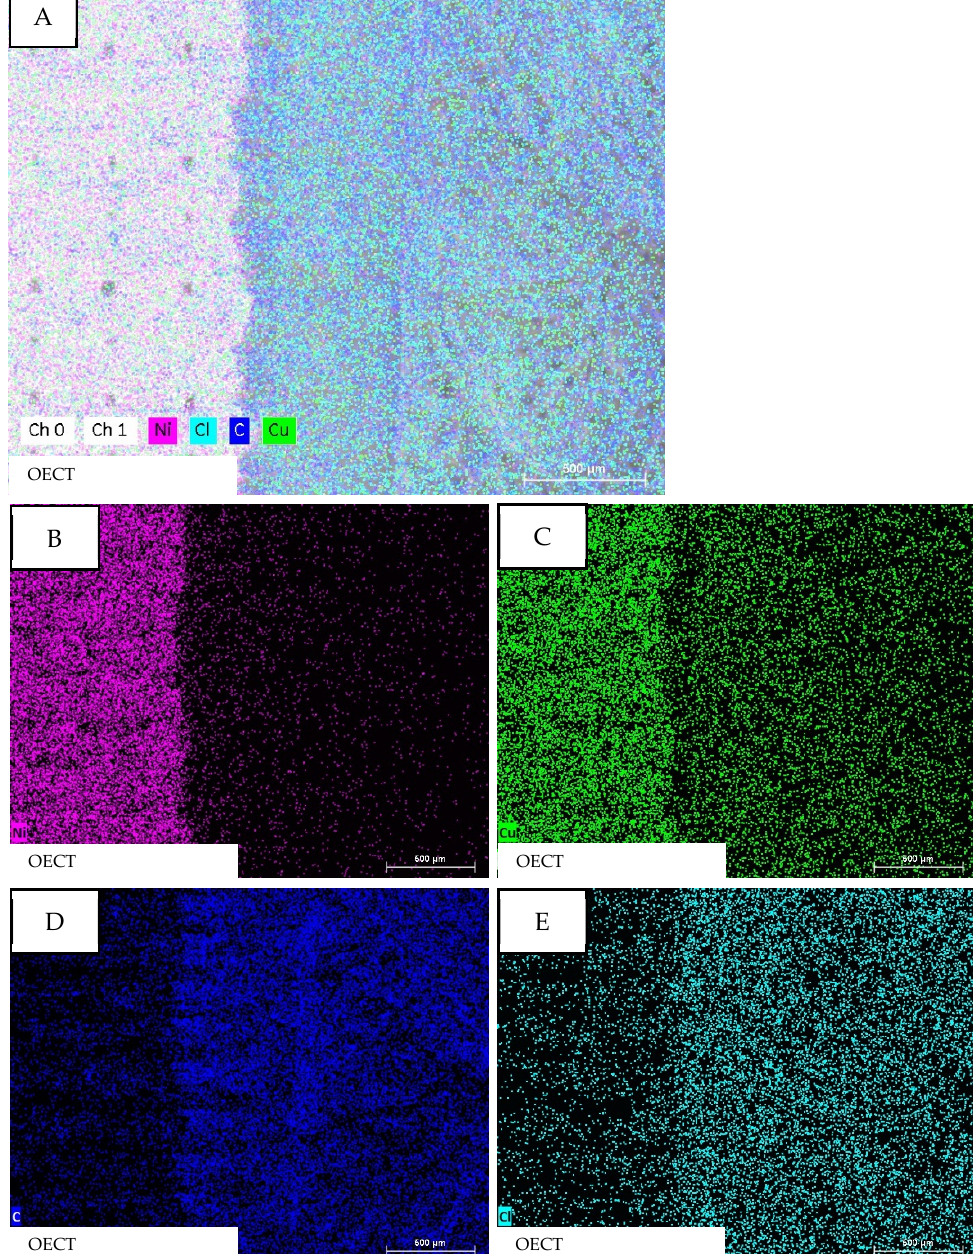
Figure 6. EDX mapping the elementary differences between the gate electrode and source/drain electrode of the readily assembled OECT. ( A ): All elements. ( B ): Nickel. ( C ): Copper. ( D ): Carbon. ( E ): Chloride.